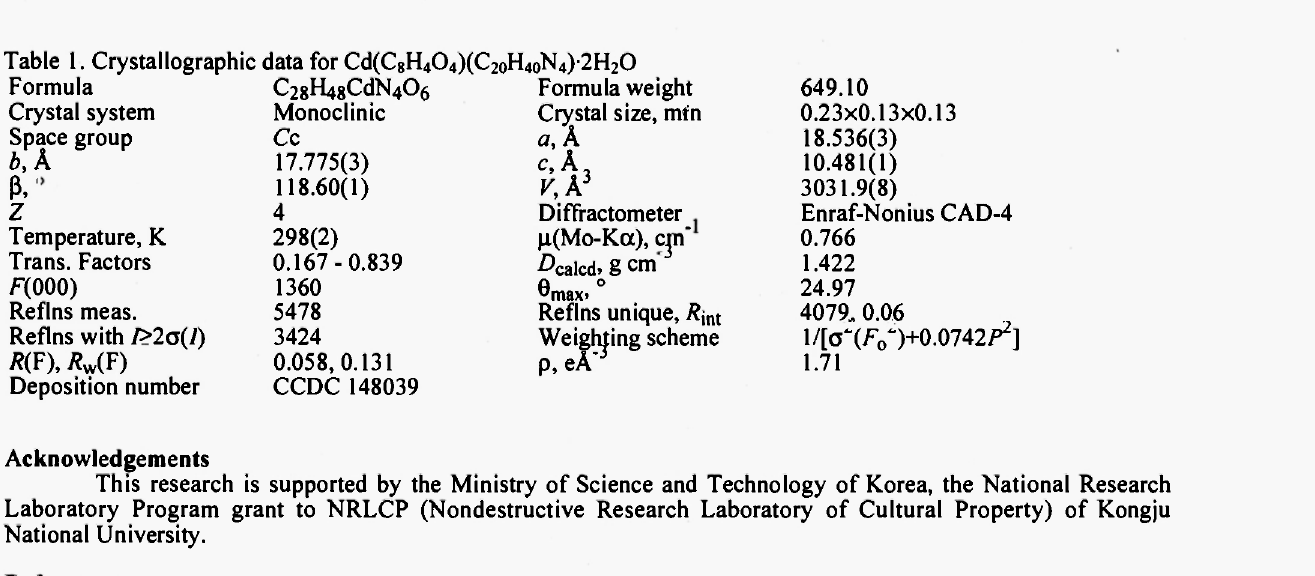
Table 1. Crystal lographic data for Cd(C 8 H 4 0 4 )(C2oH 4 oN 4 )-2H 2 0 Formula Crystal system Space group b, A ß,' Ζ Temperature, Κ Trans. Factors F(000) Reflns